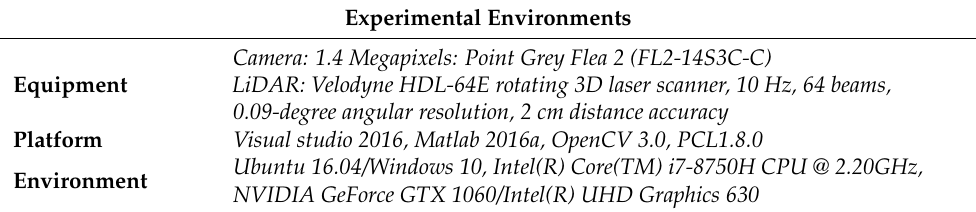
Table 1. Experimental